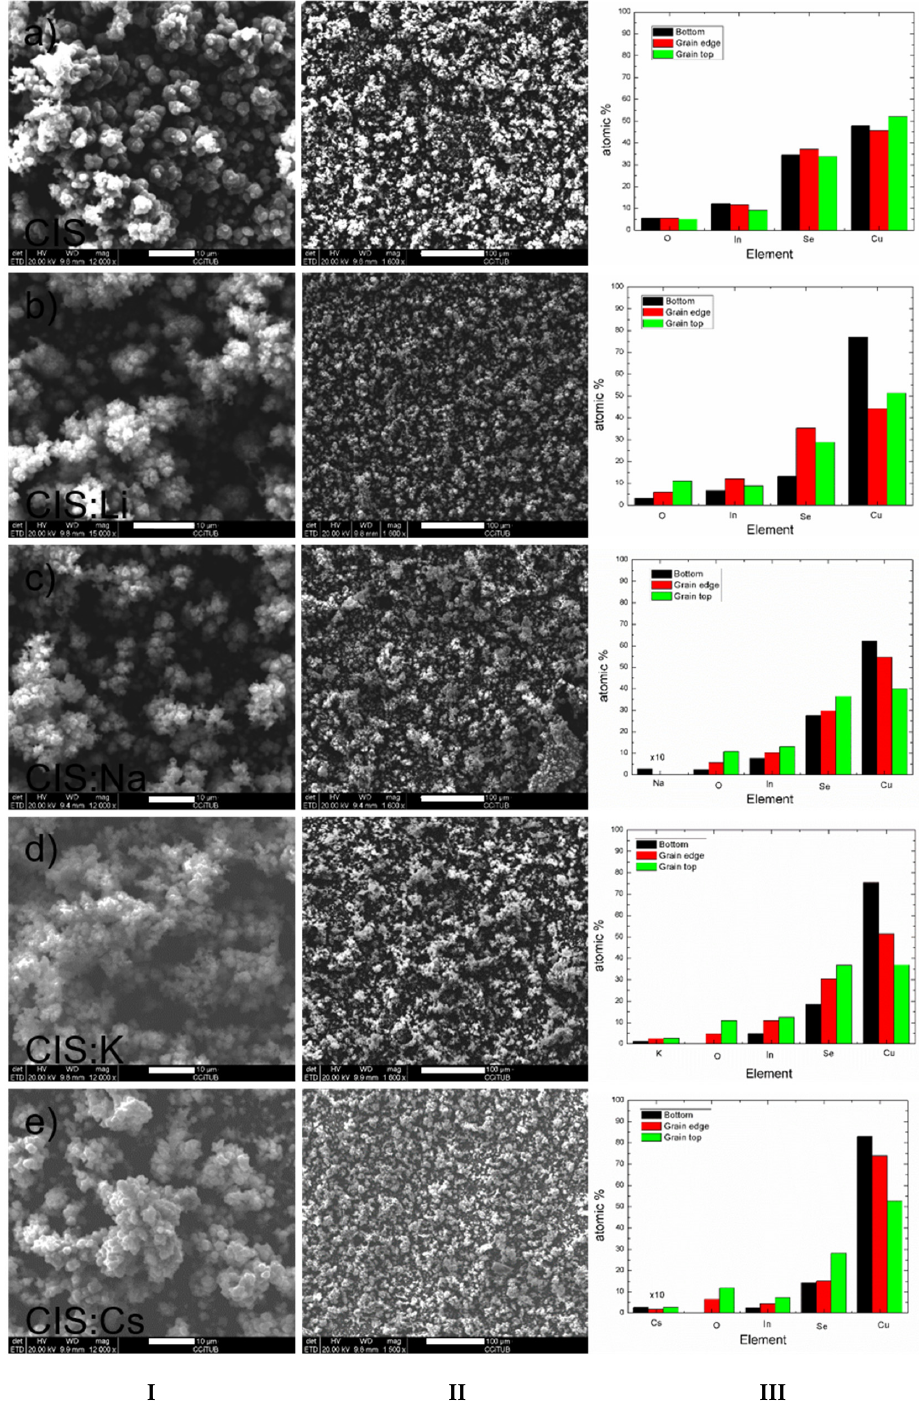
Figure 1. SEM micrographs obtained at (I) 12000× and (II) 1500×; (III) EDS data of the ( a ) CIS, ( b ) CIS:Li, ( c ) CIS:Na, ( d ) CIS:K and ( e ) CIS:Cs films obtained at the image apparent bottom (black bar), grain edge (red bar) and grain top (green bar).